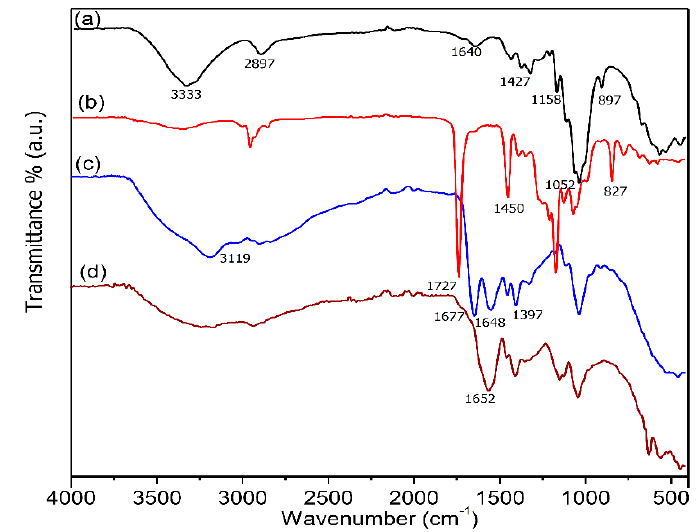
Figure 1. FT-IR spectra of ( a ) jute cellulose, ( b ) PMA-grafted cellulose, ( c ) poly(hydroxamic acid) ligand and ( d ) copper complex with poly(hydroxamic acid) ligand.